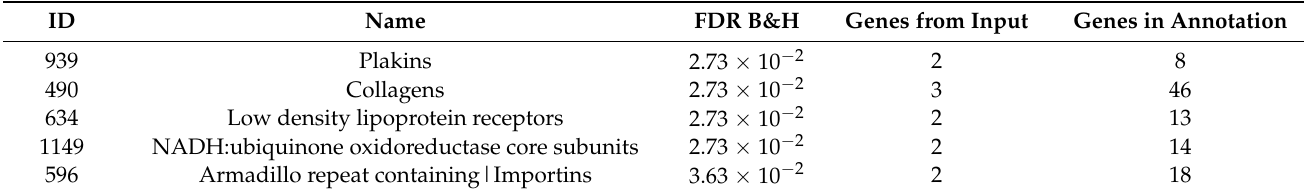
Table 5. Gene families regulated by Activin-A in FOP